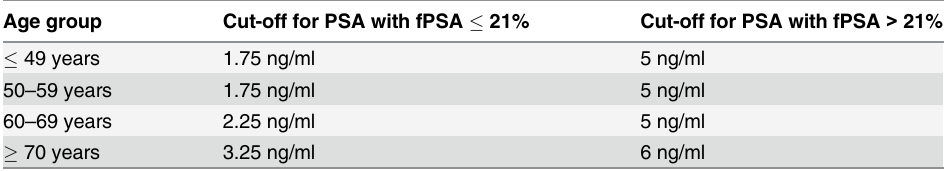
Table 3. Proposed “ new ” PSA cut offs stratified by age. Cut-off for PSA with fPSA (cid:1)